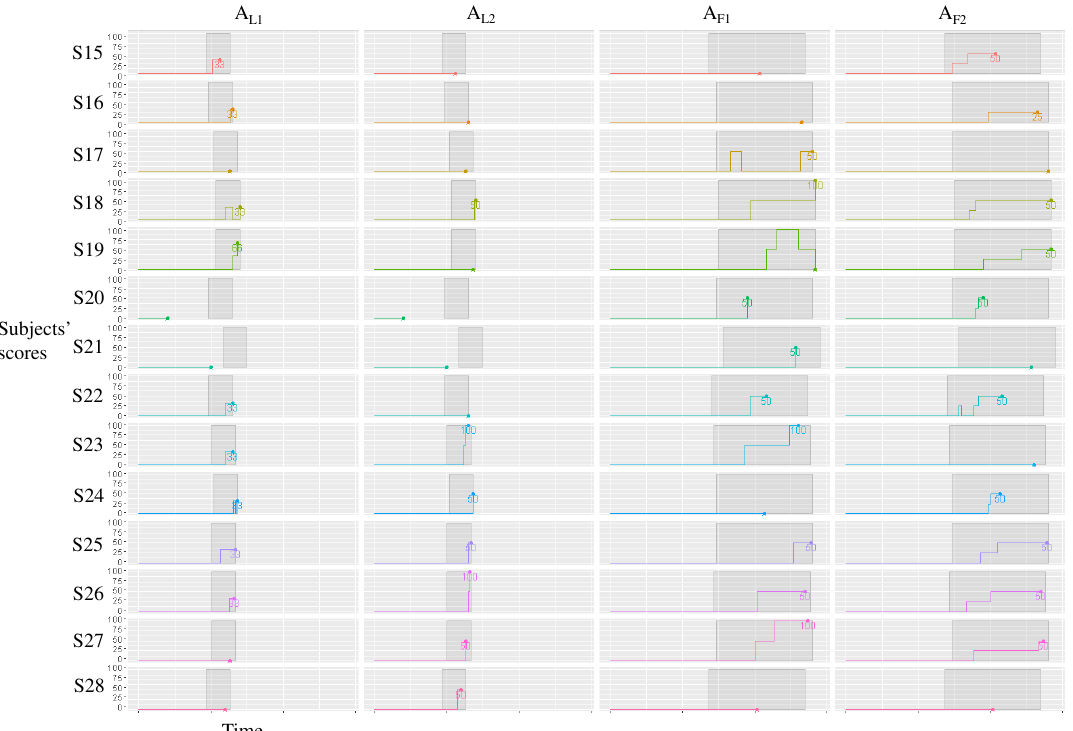
Figure 16. Changes in scores over time for each subject in the control group ( G C